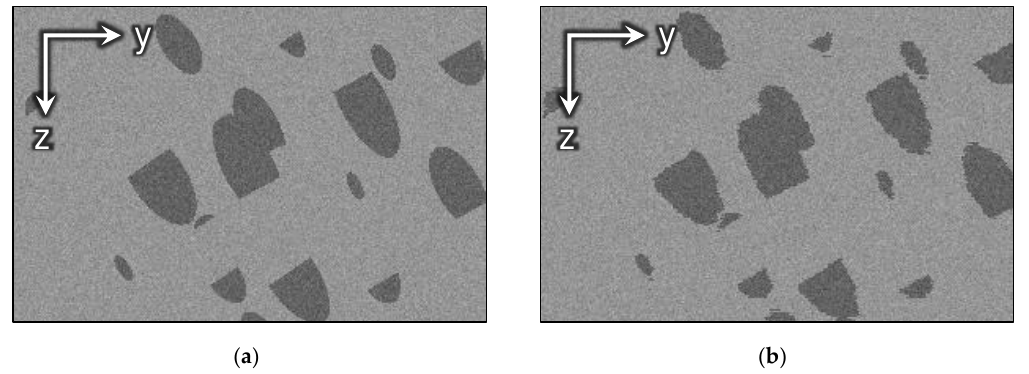
Figure 6. The side view of the synthetic image: ( a ) GT; ( b ) after displacement of slices.